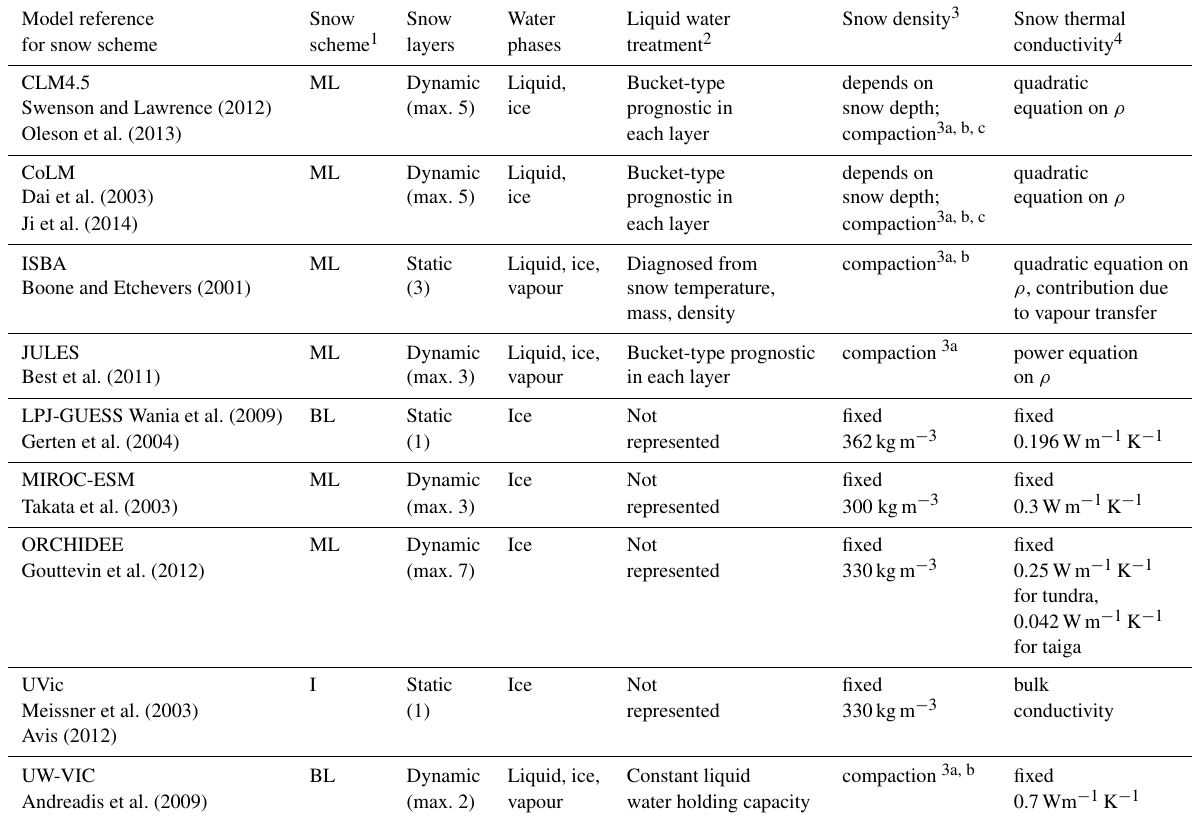
Table 1. PCN snow model